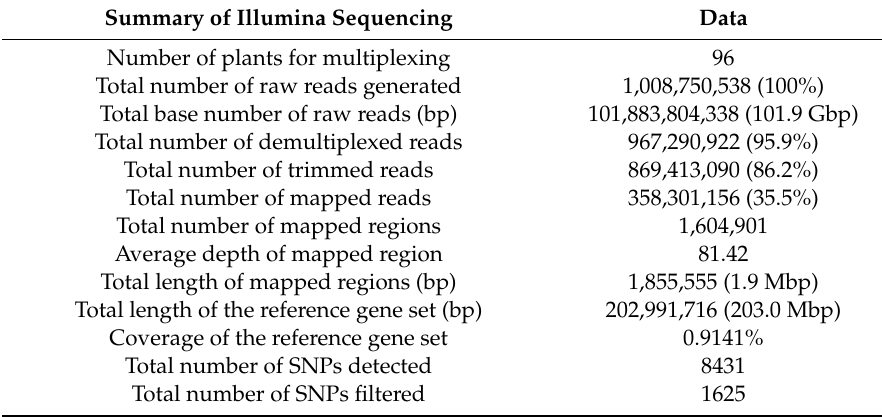
Table 1. Summary of genotyping-by-sequencing data generated by using transcriptome sequences as a reference.